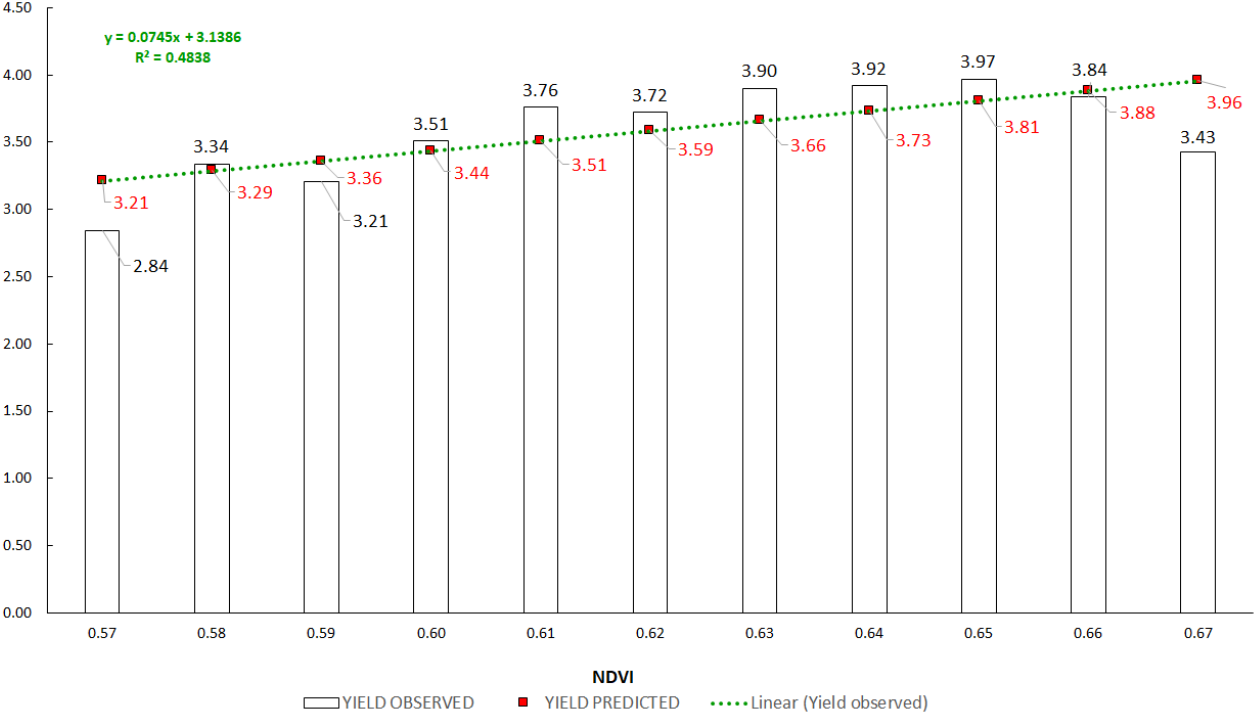
Figure 11. Graph of linear dependence of yield on NDVI. Model shows yields observed and yields predicted based on the regression analysis of NDVI and yields achieved.